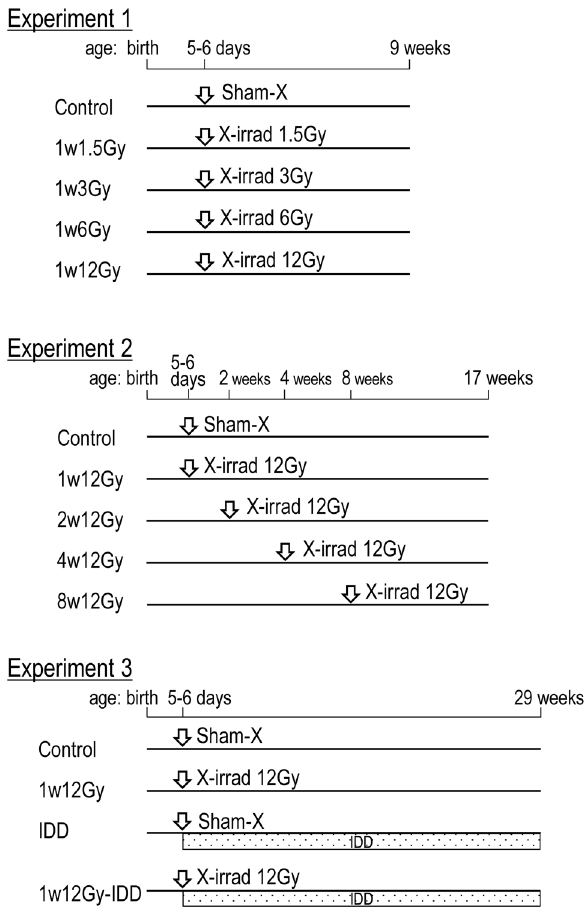
Figure 5. Schedule of the experiments. In Experiment 1 (a radiation dose–response study), rats were exposed to sham, 1.5, 3, 6, or 12 Gy of cervical X-irradiation at 5 or 6 days old and necropsied at 9 weeks old. In experiment 2 (a study of irradiation at different ages), 12 Gy of cervical X-irradiation was given at 5 or 6 days, 2, 4, or 8 weeks old. In Experiment 3 (a thyroid tumor promotion study), rats were exposed to 12 Gy of cervical X-irradiation at 5 or 6 days old. After the exposure, half of the groups were fed with IDD (The mothers were fed with IDD until weaning at 3.5 weeks